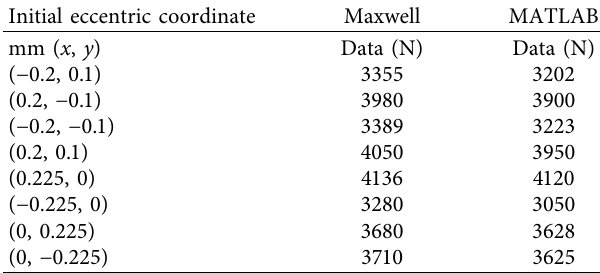
Table 2: Data table of UMP variation under eccentric direction